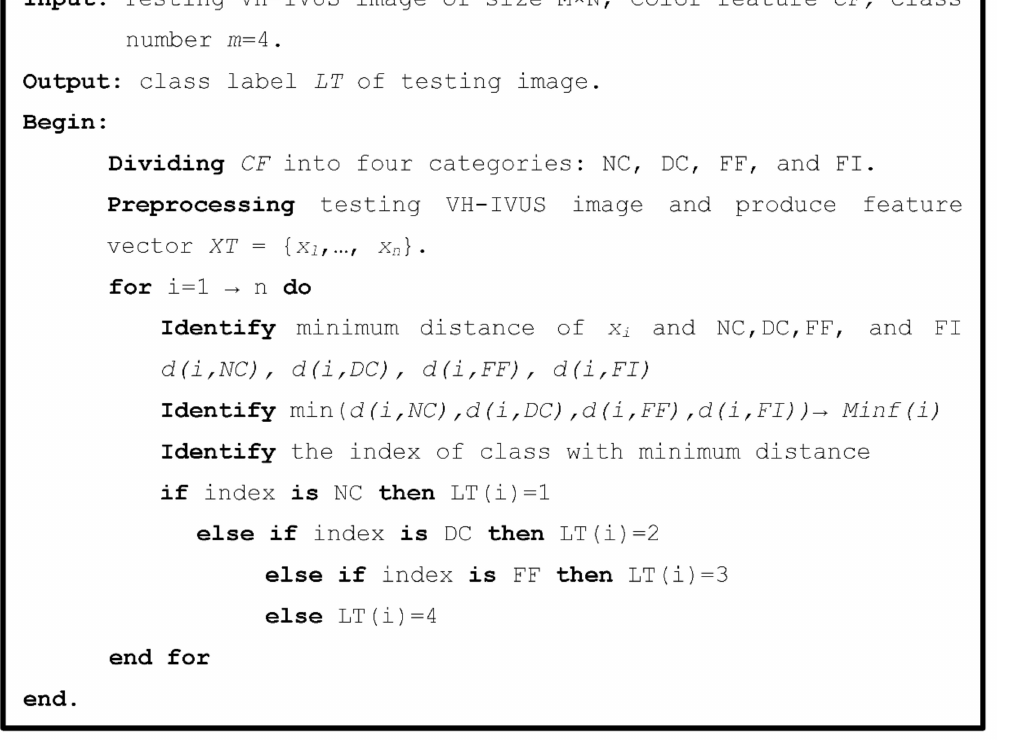
Figure 6. Pseudo-code for the proposed pixel classification using the mED algorithm.